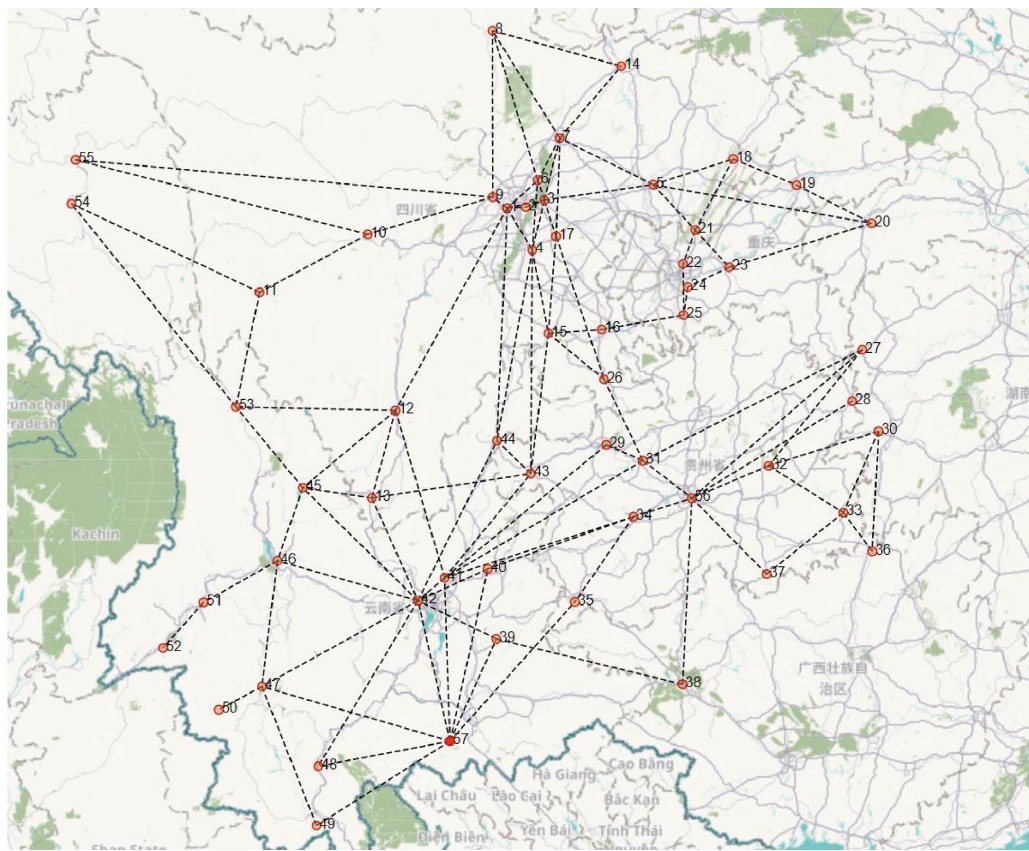
Figure 10: The new network